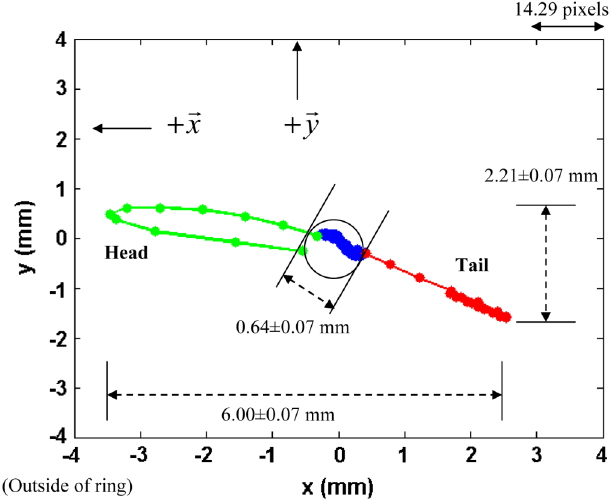
FIG. 11. Centroid measurements from the 3 ns gated camera images of the 21 mA beam, measured as a function of beam length at RC15. We subtract the position where (0, 0) refers to the centroid of the beam center from all data points. (Calibration was 0 : 07 mm = pixel in both x and y .)